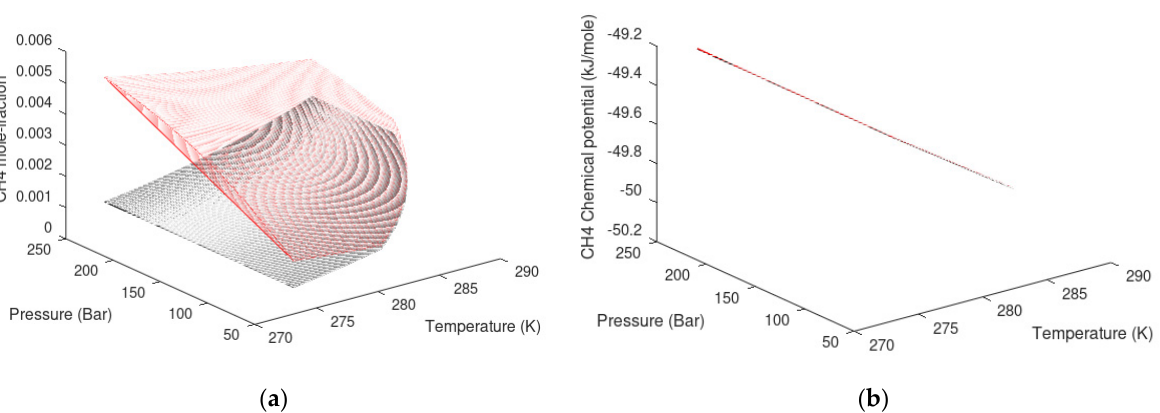
Figure 14. ( a ) Minimum mole ‐ fraction of CH 4 in surrounding water needed to keep CH 4 hydrate stable (black). Solubility of CH 4 in water (red). ( b ) Chemical potential for water corresponding to mole ‐ fractions CH 4 in water for minimum mole ‐ fractions CH 4 in surrounding water needed to keep hydrate stable (black) and chemical potentials for water in CH 4 solubility mole ‐ fractions (red).